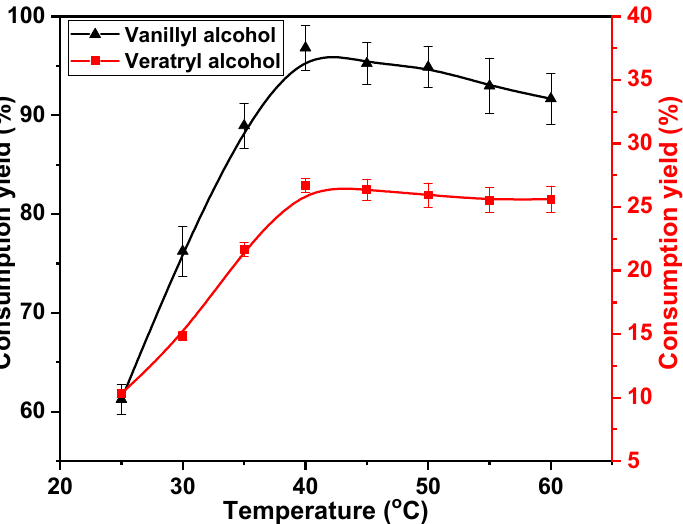
Figure 2. Effect of reaction temperature on vanillyl alcohol and veratryl alcohol consumption.